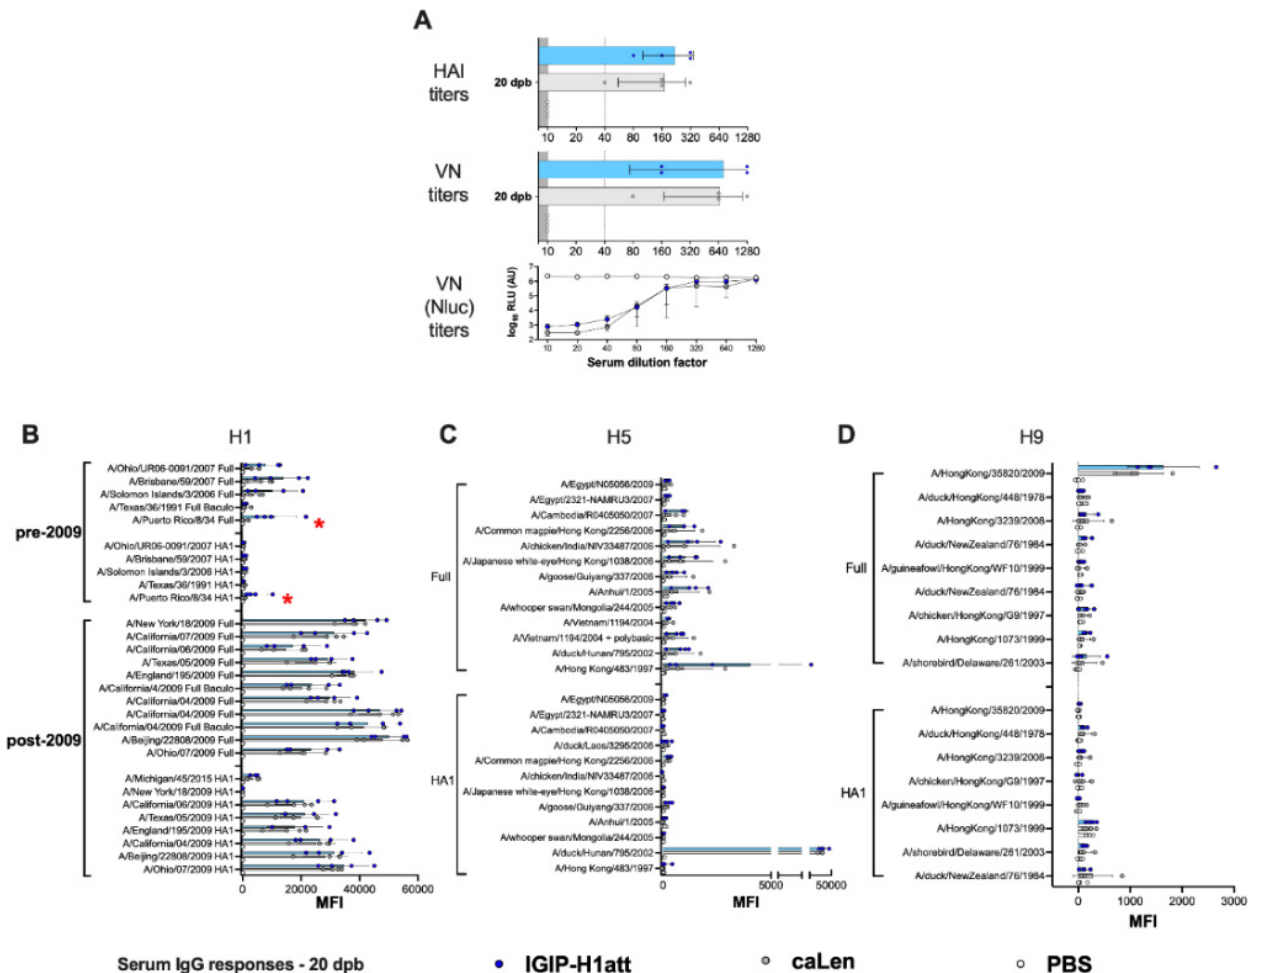
Figure 4. IgG serum responses 20 dpb in IGIP-H1att- and H1caLen-vaccinated mice. Mice ( n = 4/group) were bled at 20 dpb, and the sera were used to evaluate HAI, VN and antibody reactivity against a panel of influenza antigens printed on a microarray. Samples from IGIP-H1att- and H1caLen-vaccinated mice indicated by blue dots/bars and grey dots/bars, respectively. PBS control samples are shown as white dots/bars. ( A ) HAI and VN titers. VN titers were established using a recombinant Ca/04 virus carrying PB1-Nluc and evaluated by two independent methods at 48 hpi using a classical HA assay and Nluc activity. Levels of IgG antibodies against ( B ) H1, ( C ) H5 and ( D ) H9. The reactivity of each serum sample against each antigen is shown by dots/antigen and the results are expressed as the mean of fluorescent intensity (MFI) of each value ± SD. The statistically significant differences between IGIP-H1att and caLen are depicted with red asterisks. Figure 5 . IgA serum responses 20 dpb in IGIP-H1att- and H1caLen-vaccinated mice. Same set of samples from Figure 4 probed for IgA antibodies against ( A ) H1, ( B ) H5 and ( C ) H9 using the influenza antigen array. The reactivity of serum samples is expressed as described in Figure 4 and results shown as MFI ± SD. IGIP-H1att samples in blue dots/bars. H1caLen samples in grey dots/bars. PBS control samples in white dots/bars. No significant differences were observed.